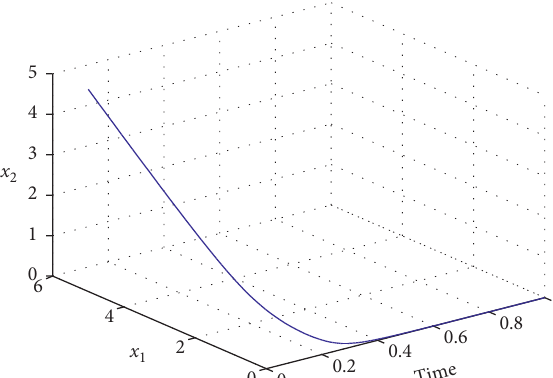
Figure 4: Transient behavior of ( x